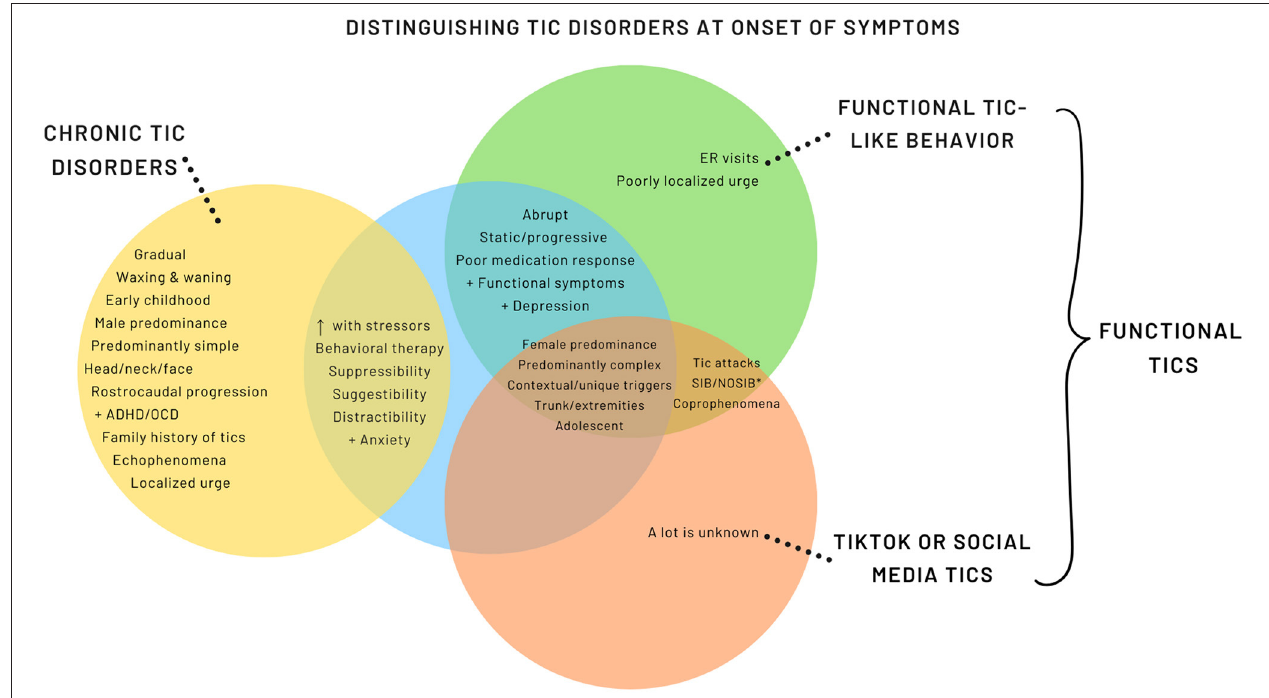
FIGURE 2 | Distinguishing Tic Disorders at Onset of Symptoms. *SIB, Self-injurious behavior; NOSIB, Non-obscene socially inappropriate